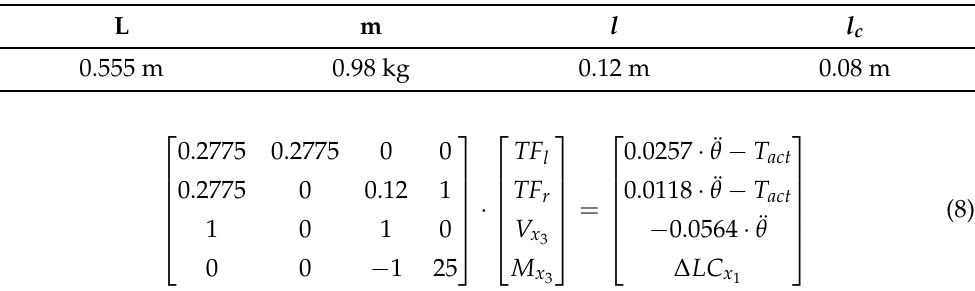
Table 1. Characteristics of the robotic